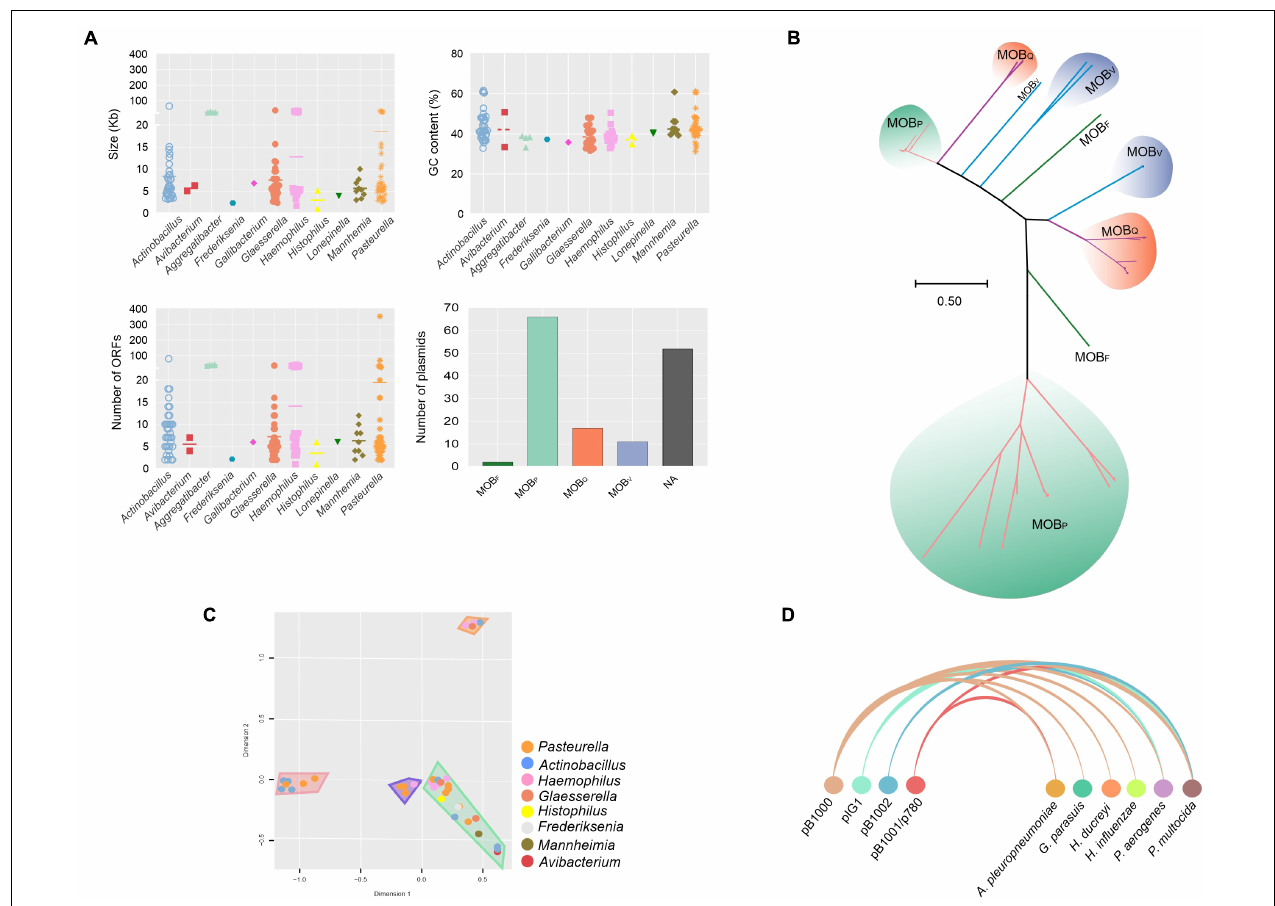
FIGURE 5 | General characteristics and clustering of plasmids found in the Pasteurellaceae family. (A) A general overview of plasmids in the Pasteurellaceae family grouped by genera according to plasmid size (top-left graph), GC content (top-right graph), ORF content (bottom-left graph), and relaxase family (bottom-right graph). (B) Evolutionary history of mob genes from plasmids inferred by using the Maximum Likelihood method based on the General Time Reversible model. The tree is drawn to scale, with branch lengths measured in the number of substitutions per site. (C) A multidimensional graph for analysis of the potentially non-mobilizable plasmid by sequence comparison. Clusters are highlighted in the graph in color-codes that represent the taxonomic group present in that taxon of plasmids. (D) Arc diagram representing four plasmids identified in different species/genomes, pB1000, pIG1, pB1002, and pB1001/pB780 (there is no deposit of the plasmid pB1000 identified in A. pleuropneumoniae , however, this has already been previously reported (Bossé et al.,